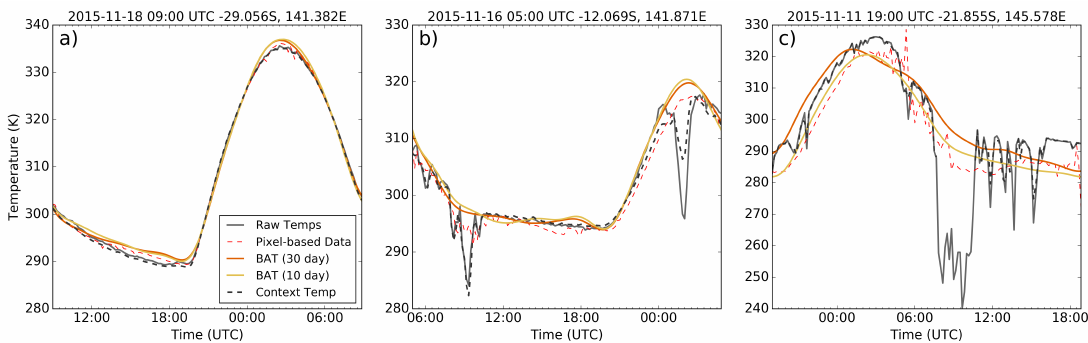
Figure 4. Examples of model fitting using the four training data derivations. ( a ) shows a typical day with less than ten cloud instances, ( b ) shows a day with between 20–30 instances of cloud, and ( c ) is typical of a day with more than 70 identified cloud